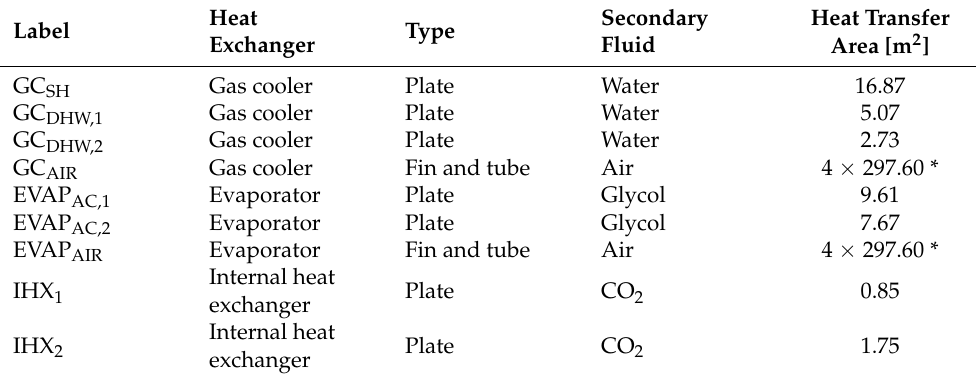
Table 1. Heat exchangers characteristics based on commercial available